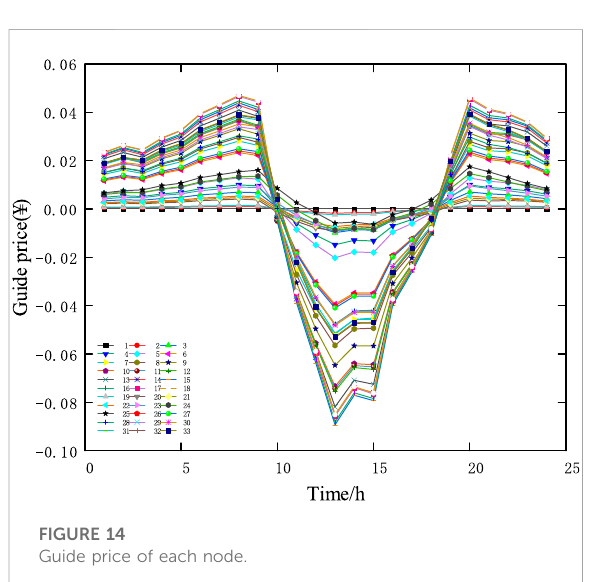
FIGURE 14 Guide price of each